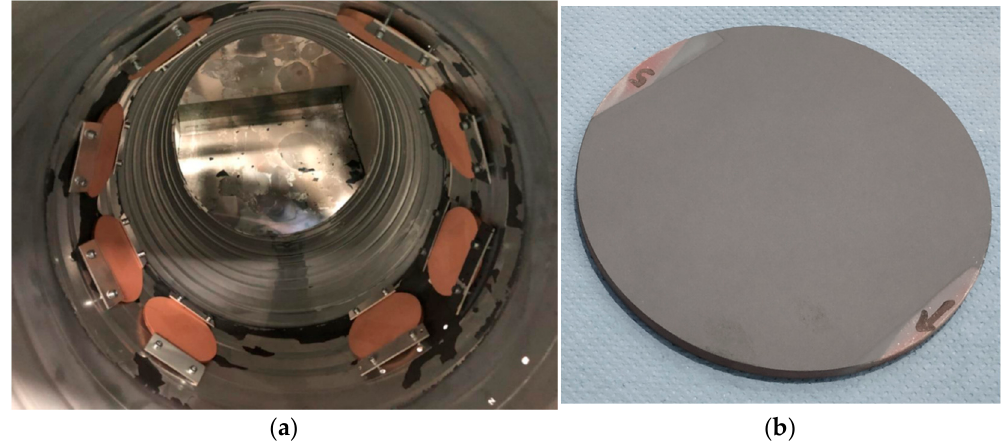
Figure 8. Test samples mounted in dummy steel tube prior to plasma spray coating operation ( a ). Planar test sample after plasma spray deposition of the oxide ceramic ( b ). See more details in text.